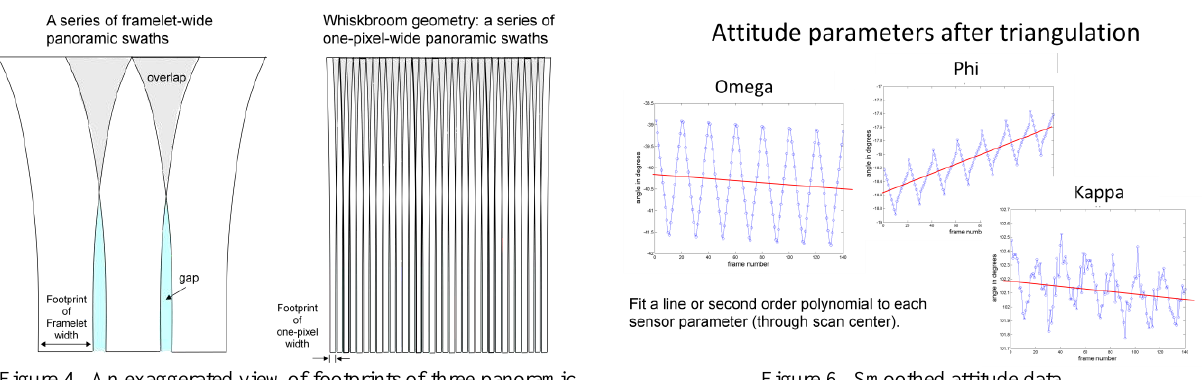
Figure 4. An exaggerated view of footprints of three panoramic images (left side) and several columns of a whiskbroom image (right side)